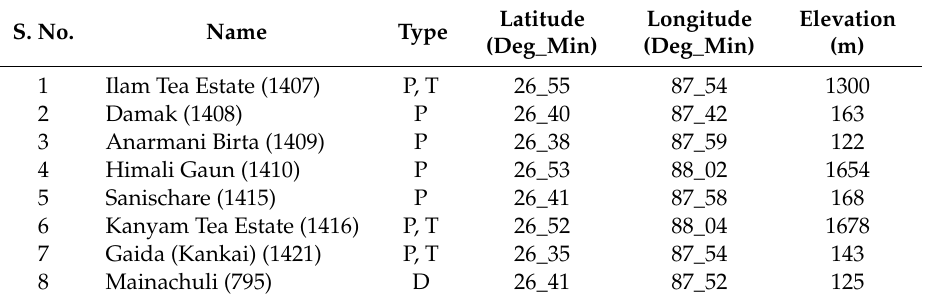
Table 1. Details of the stations and data used for the analysis (P is Precipitation, T is Temperature and D is the